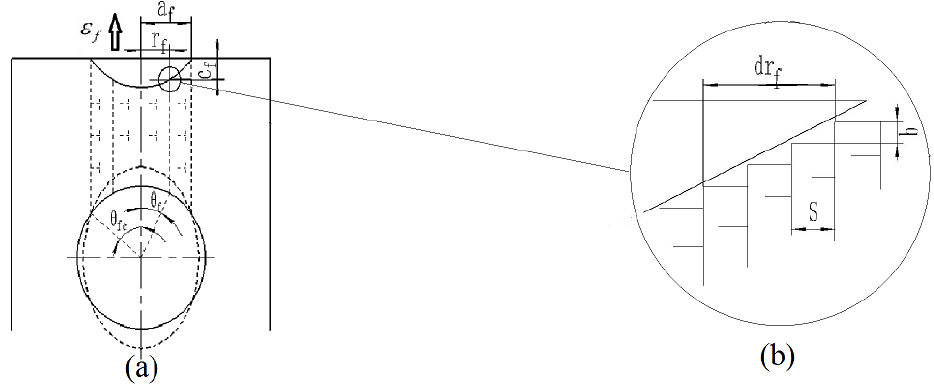
Figure 4. Schematic of indentation deformation, ( a ) the GNDs array in ferrite matrix, ( b ) the local amplification at r i of (a).